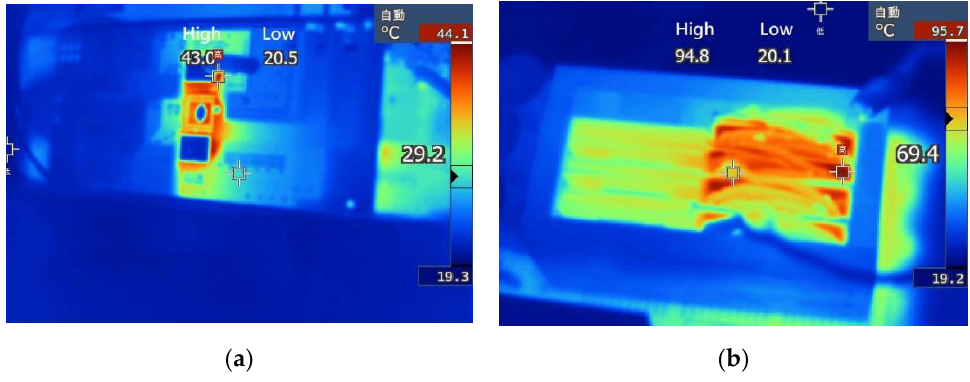
Figure 18. Measured temperatures: ( a ) primary-side switch and ( b ) secondary winding of the transformer.